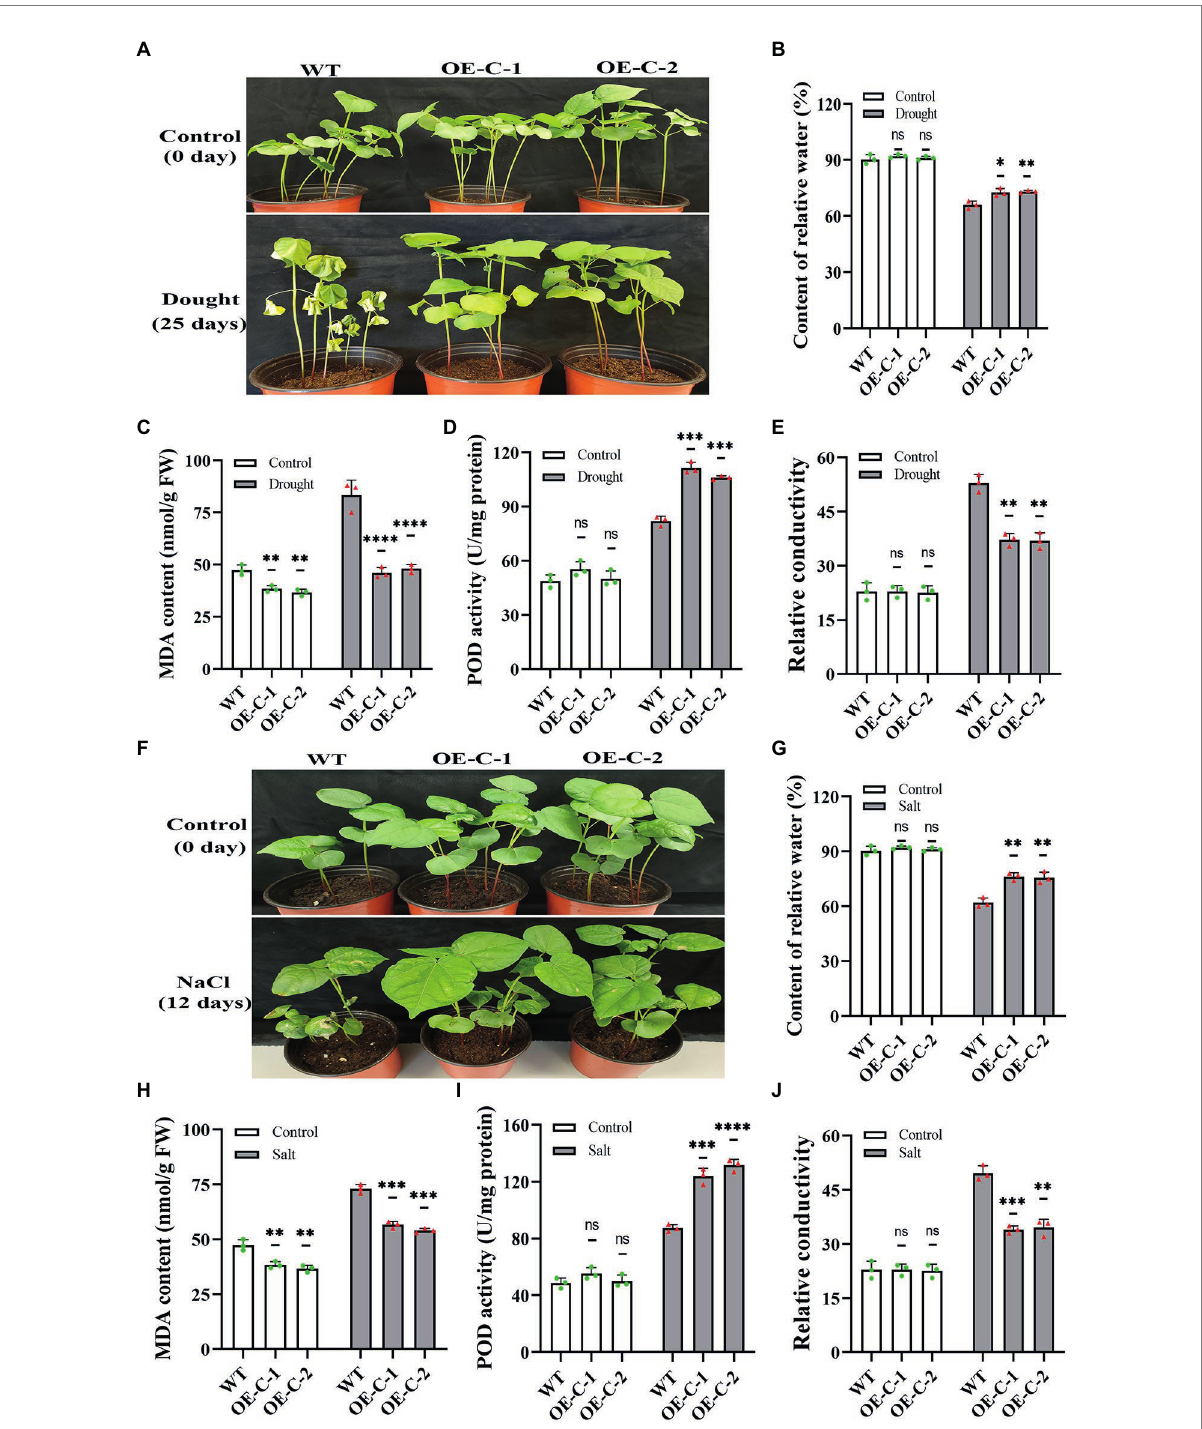
FIGURE 4 Phenotype and physiological indexes of DgCspC transgenic cotton under drought and salt stress. (A) Phenotype of transgenic and wild-type cotton line under natural drought and rehydration; (B) relative water content; (C) MDA content; (D) POD content; (E) relative conductivity; (F) phenotype of transgenic and wild-type cotton lines under salt treatment; (G) relative water content under salt stress. (H) MDA content under salt stress; (I) POD content under salt stress; (J) relative conductivity under salt stress; Asterisks indicate significant differences between WT and the OE-C-1/ OE-C-2 transgenic lines. (* p < 0.05, ** p < 0.01, *** p < 0.001, **** p < 0.0001 for comparisons between the transgenic lines and wild-type plants by Student’s t